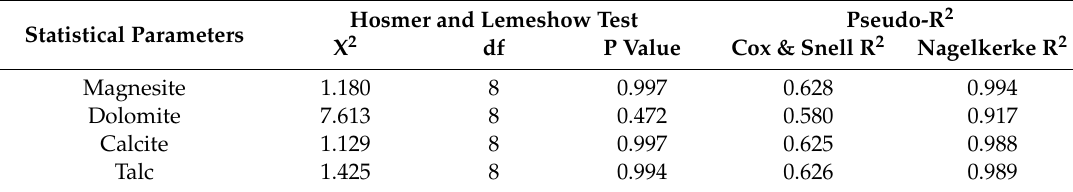
Table 9. The statistical parameters of the logistic regression models.